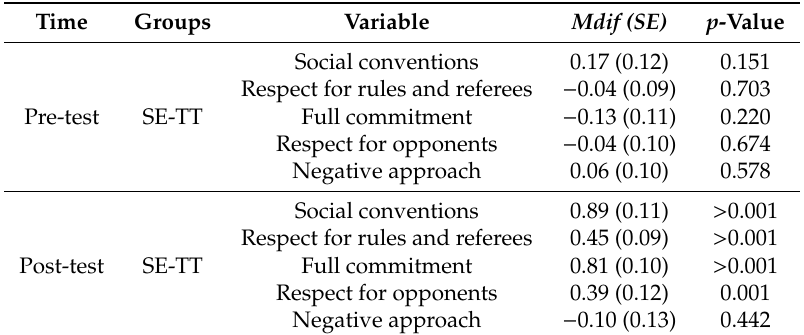
Table 4. Analysis of mean di ff erences between the Sport Education and Traditional Teaching groups (pre-test and post-test) for sportsmanship orientations. Time Groups Variable